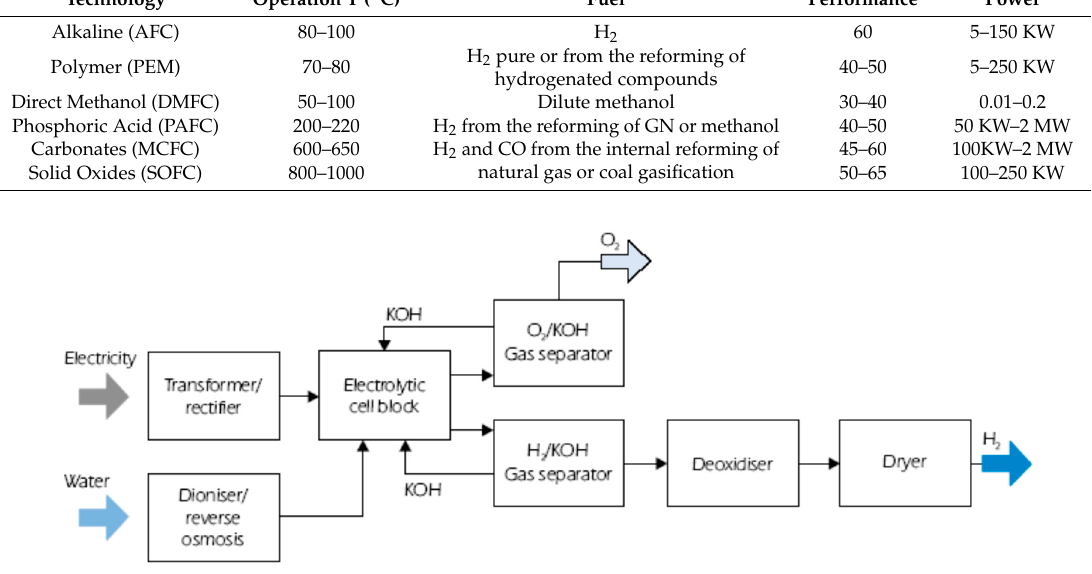
Figure 1. Diagram of an alkaline electrolyze [12].